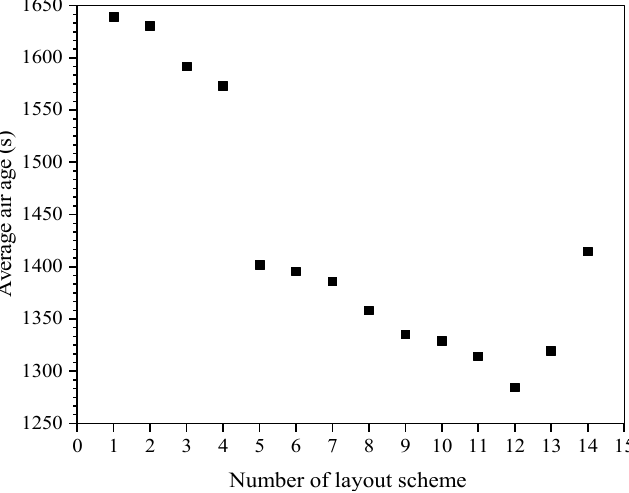
Figure 4. Comparison of average air age in sample rooms under different schemes.